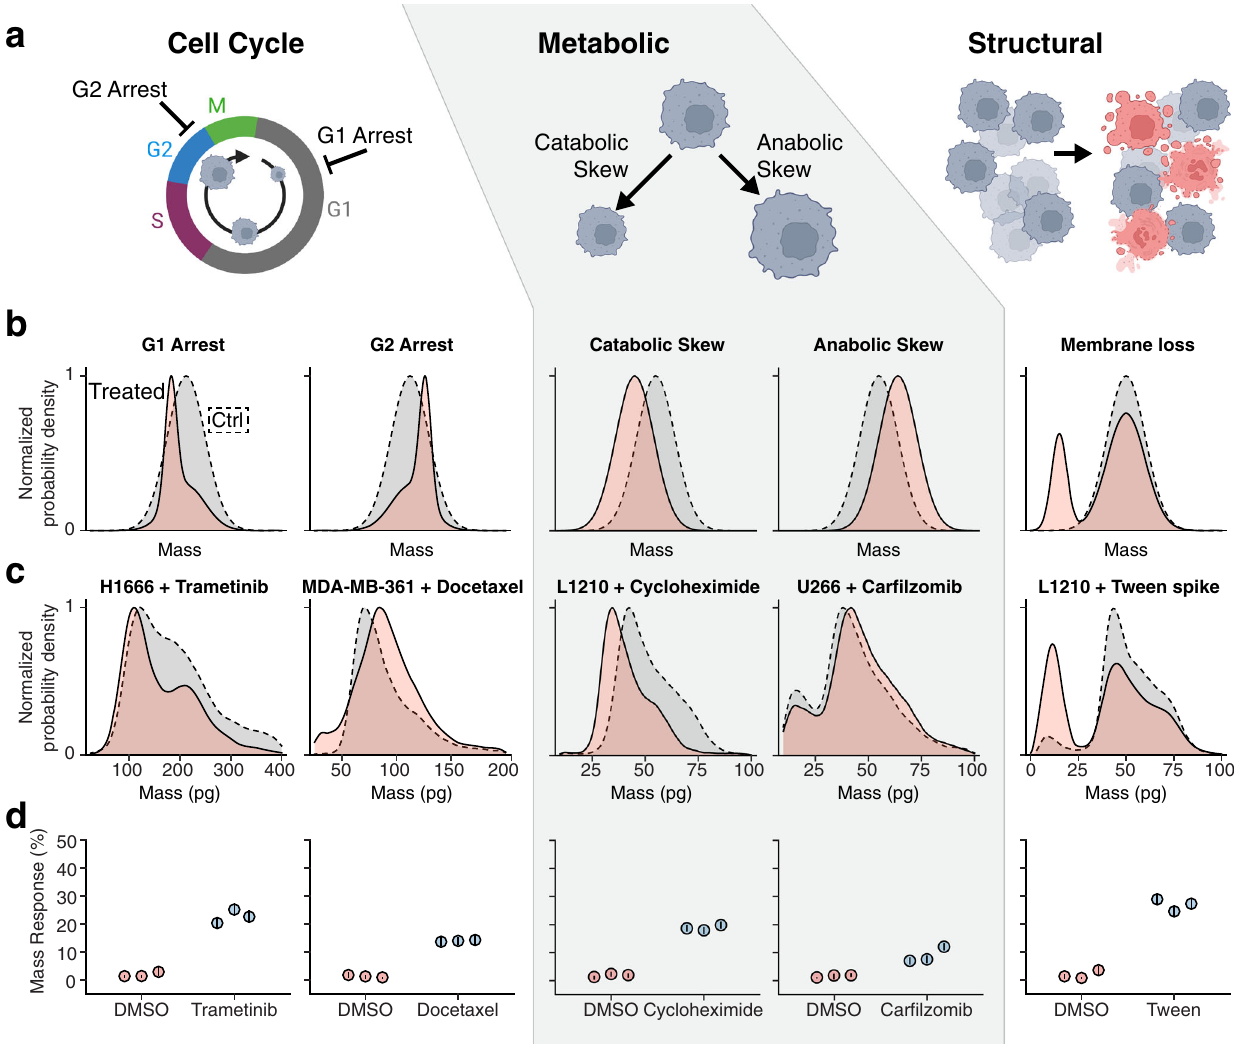
Fig. 4 Mass responses to drugs with various mechanisms of action. Therapies with different mechanisms of action (MOA) induce different characteristic mass response signatures. As depicted in ( a ) these MOA signatures capture drug effects that can be loosely classi fi ed into three general categories, including cell cycle arrest, metabolic disruption, or loss of structural integrity. b Schematic demonstrations of the changes in mass distributions between a control population (gray fi ll, dotted line) and a drug-treated population (red fi ll, solid line) caused by G1 arrest, G2 arrest, catabolic skew, anabolic skew, or cell membrane loss. c Example experimental mass distribution changes in response to drug treatment corresponding to each schematic result presented directly above in ( b ). d Mass response measurements collected with three different instruments (individual points with error bars corresponding to the 95% con fi dence interval of EMD for each system de fi ned by 5000 random samples of 2500 cells), corresponding to the experimental data presented directly above in ( c